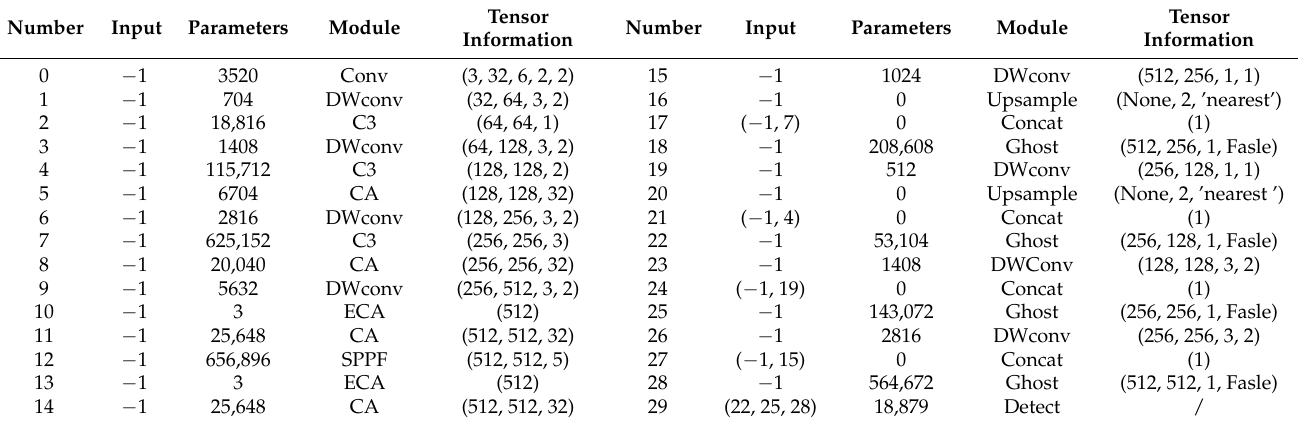
Table 7. The YOLOv5 lightweight network structure. The input “ − 1” in the table represents the input from the previous layer. The tensor information includes the number of input channels of the module, output channels, convolution kernel size, step length, and grouping.